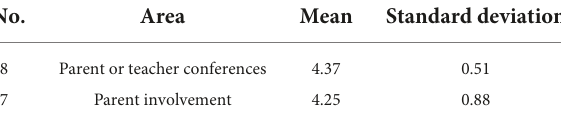
TABLE 9 Teachers’ perceptions associated with parent considerations in the